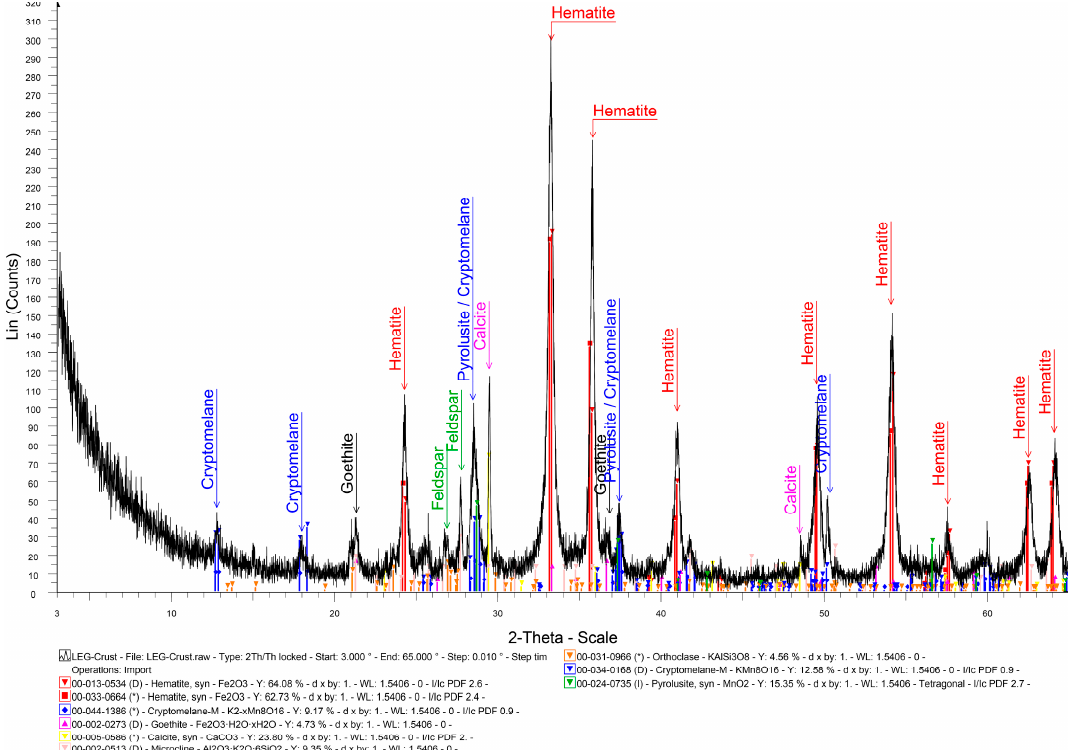
Figure 2. X-ray powder diffraction (XRD) pattern of a Fe-Mn crust sample from the Legrena valley, Lavrion. The high background, the low intensity (number of counts) and the broad peak shape suggest a low grade crystallinity of the major mineral phases.